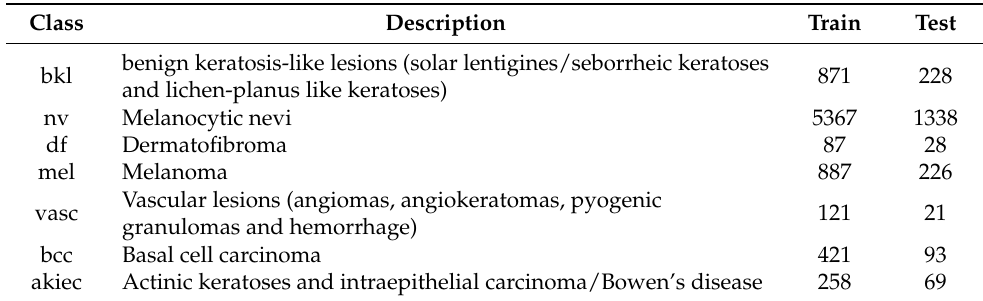
Table 2. The HAM10000 dataset details.